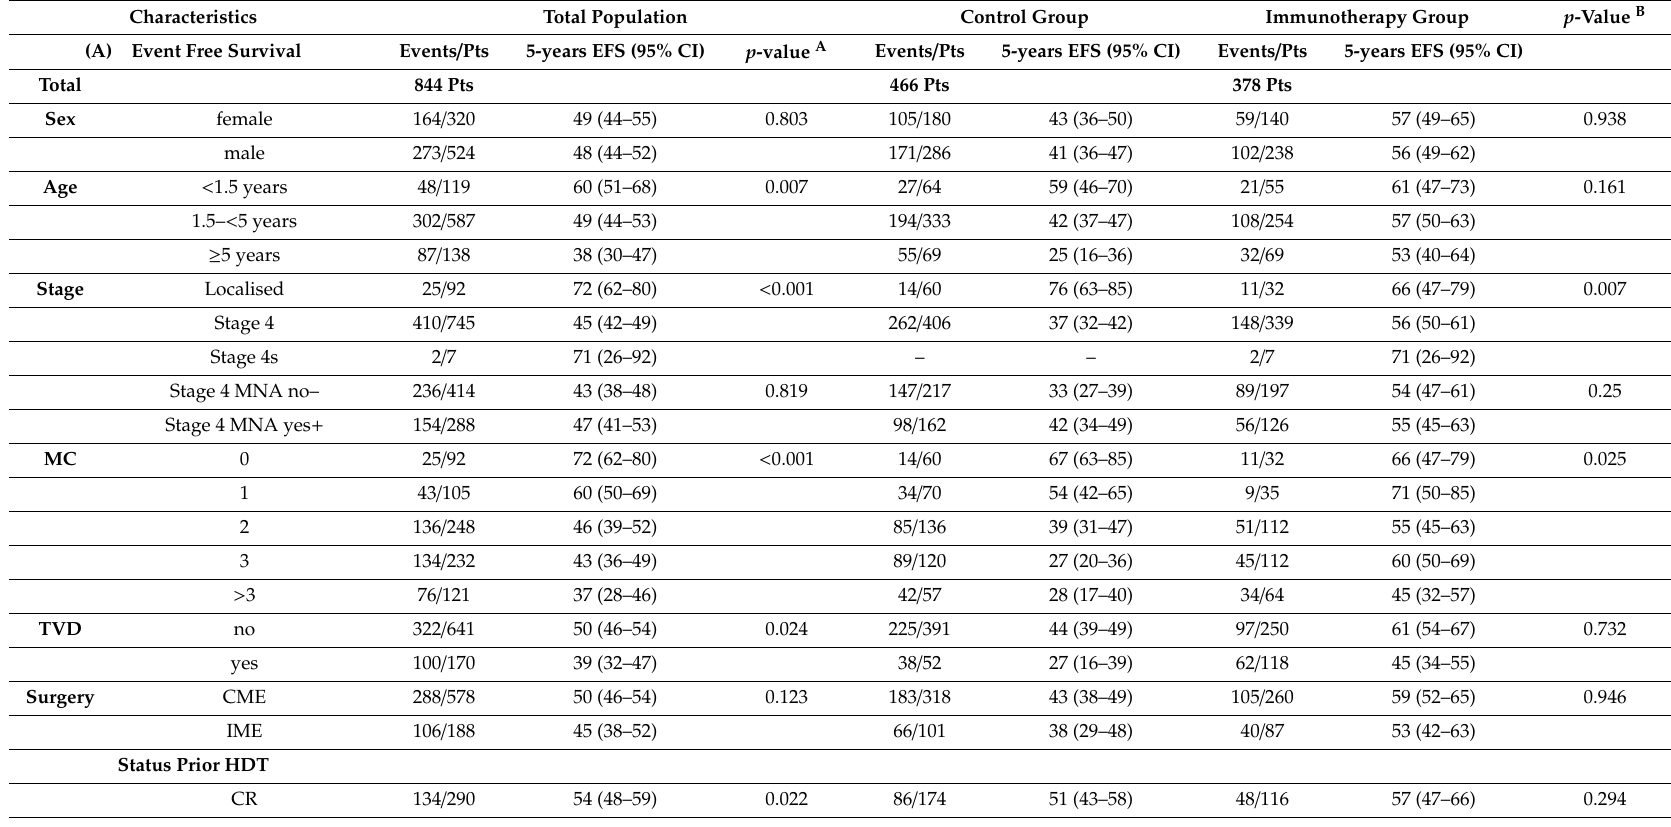
Table 2. Outcomes according to risk factors and subgroups. (2A) Event-free survival and (2B) overall survival. Pts (patients); 95% CI (95% confidence interval); p - value (probability value for A: comparison according to risk factor and B: for interaction); MNA ( MYCN amplification); - (not present) and + (present); MC (metastatic compartments); TVD (topotecan, vincristine and doxorubicin); HDT (high-dose chemotherapy); BuMel (high-dose chemotherapy with busulfan and melphalan); CEM (high-dose chemotherapy with carboplatin, etoposide and melphalan); CR (complete remission); VGPR (very good partial remission; PR (partial remission); CME (complete macroscopic excision) and IME (incomplete macroscopic